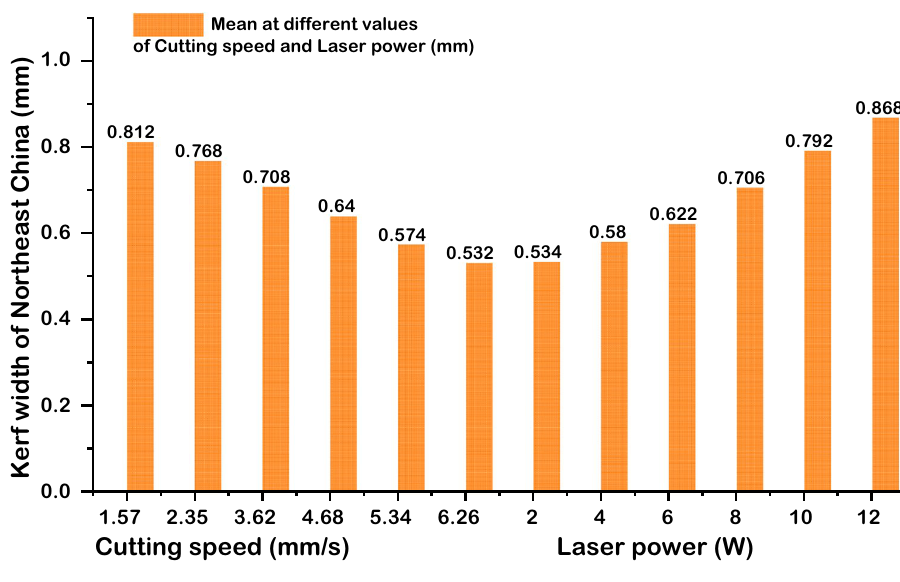
Fig. 19 Illustration of North- east China ash kerf width under M and M 1